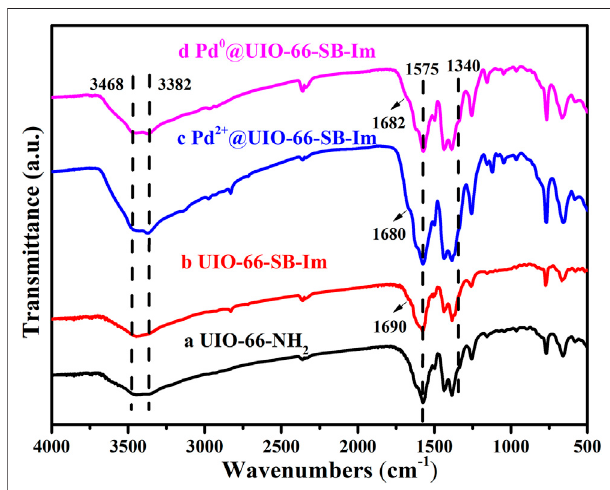
FIGURE 4 | Fourier transform infrared spectroscopy (FTIR) spectra of UIO-66 – NH 2 , UIO-66 – SB – Im, Pd 2+ @UIO-66 – SB – Im, and Pd 0 @UIO- 66 – SB – Im.